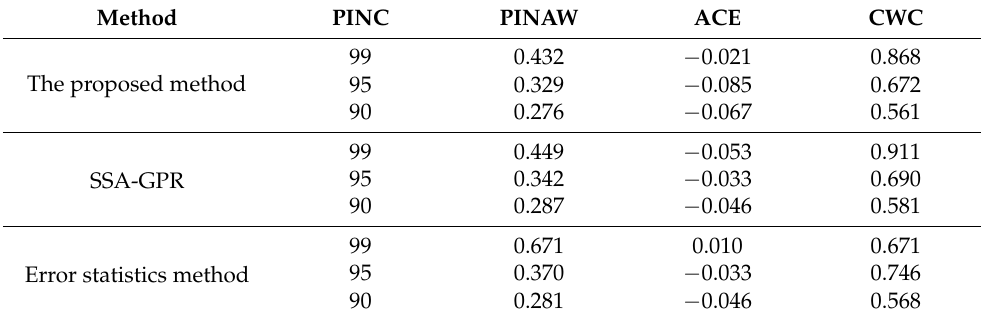
By setting different reserved deloading levels, the calculated maximum releasable rotor kinetic energy, over-speed control power reserve, and pitch angle control power reserve of wind power are demonstrated in Figure